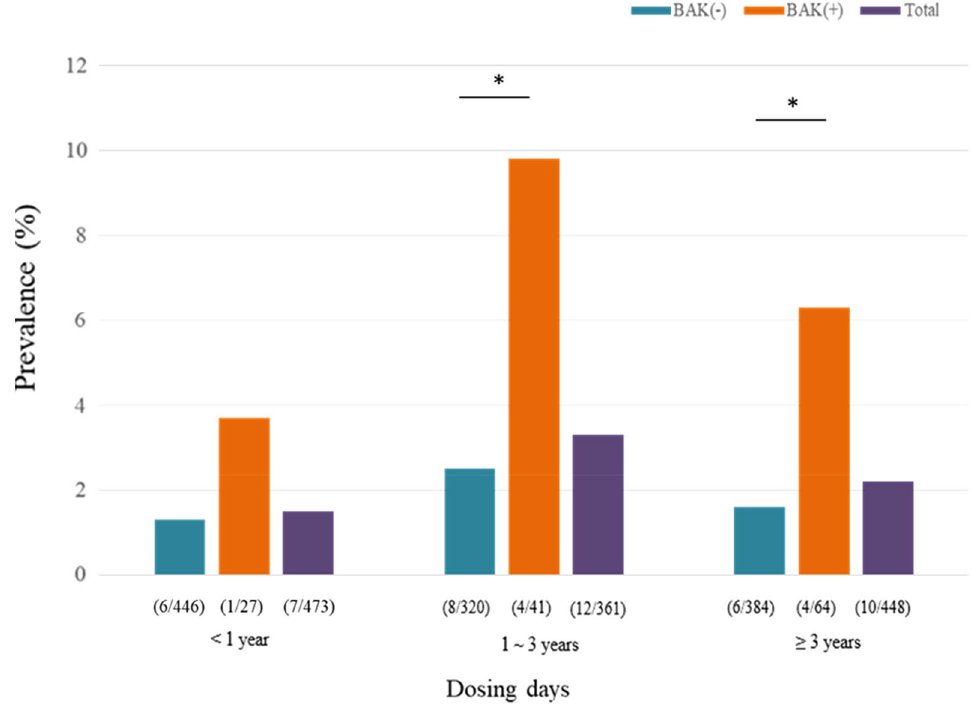
Figure 3. Prevalence of periorbital dermatitis related to dorzolamide/timolol according to dosing